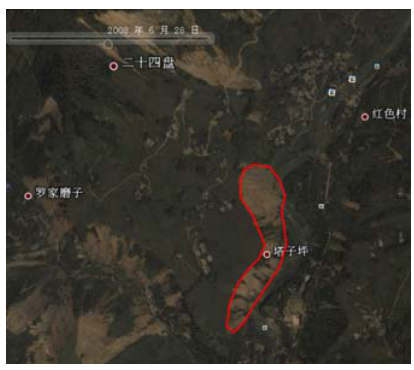
Figure 2. Hongkou landslide area in Sichuan